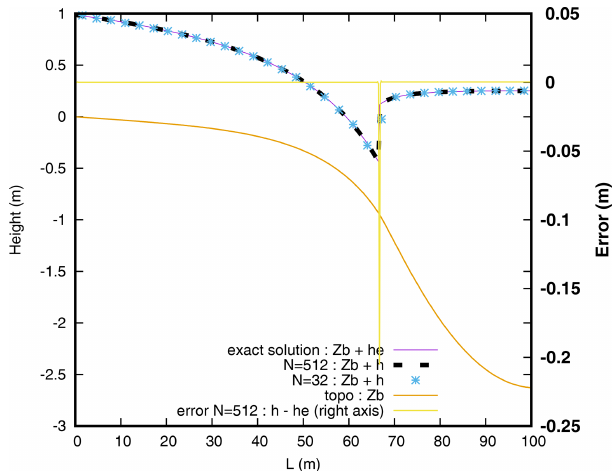
Figure 5. Comparison between the simulation with the analytical solution of the transonic test case for two different resolutions.